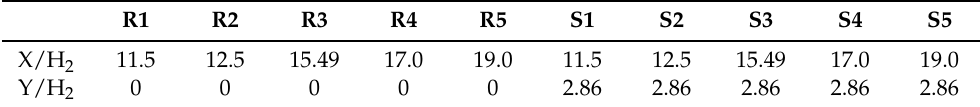
Figure 3. Line probes S1 to S5 and R1 to R5 on the planes S and R used to evaluate the results. The lines indicate the planes that are oriented normal to the channel bottom. Table 3. Coordinates of the line